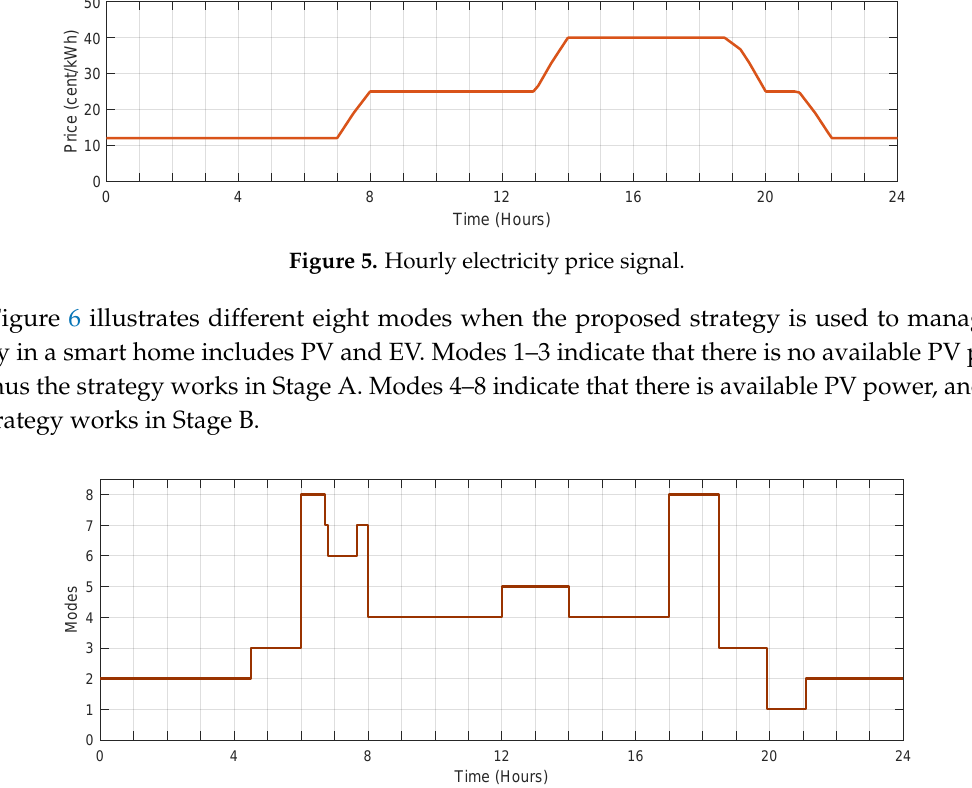
Figure 6. Different operation modes achieved by the proposed strategy when used to manage the energy in a smart home equipped with PV and EV.